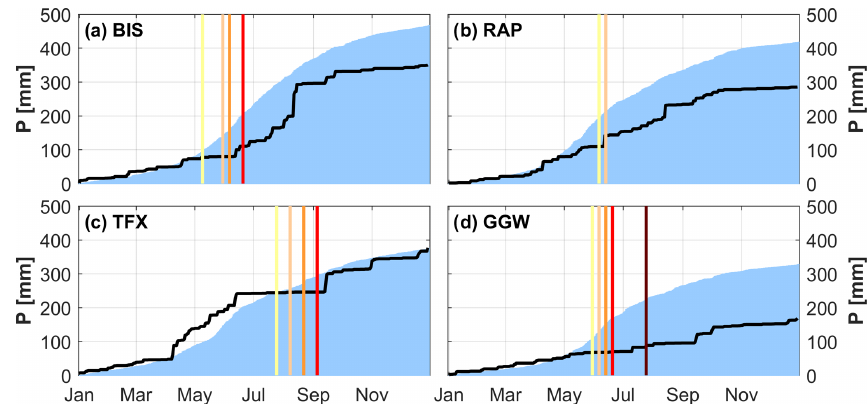
Figure 2. Cumulative annual precipitation for 2017 (black line) compared to 30-year average precipitation (1987–2016, shaded area) for (a) Bismarck, ND; (b) Rapid City, SD; (c) Great Falls, MT; and (d) Glasgow, MT. Vertical lines indicate onset of drought (D0 – yellow to D4 – dark red).